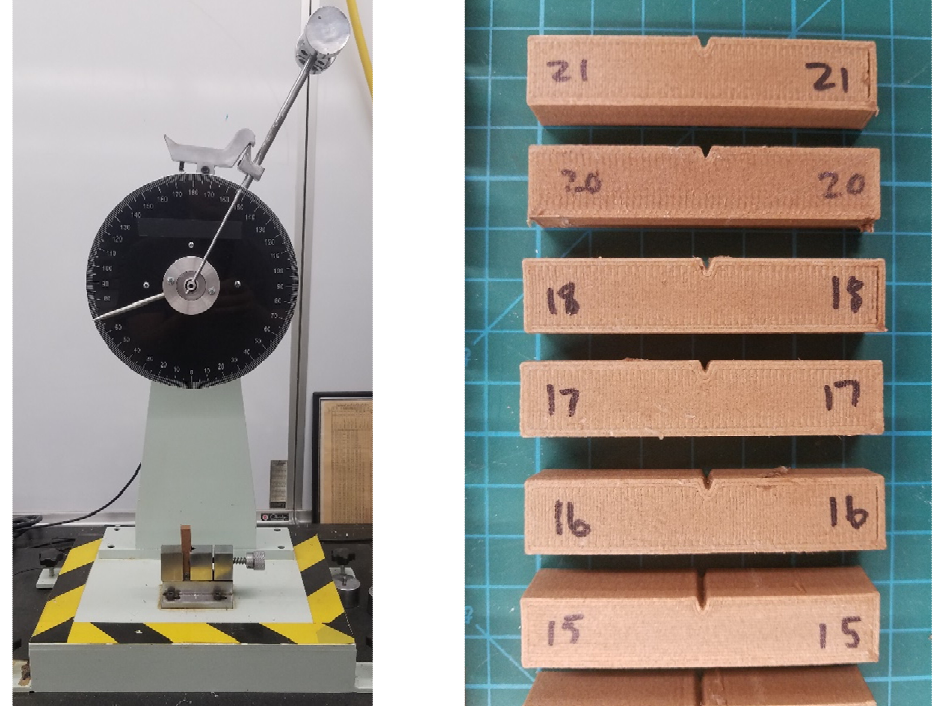
Figure 5. Impact Testing Setup ( Left ) and Examples of Impact Testing Specimens ( Right ).